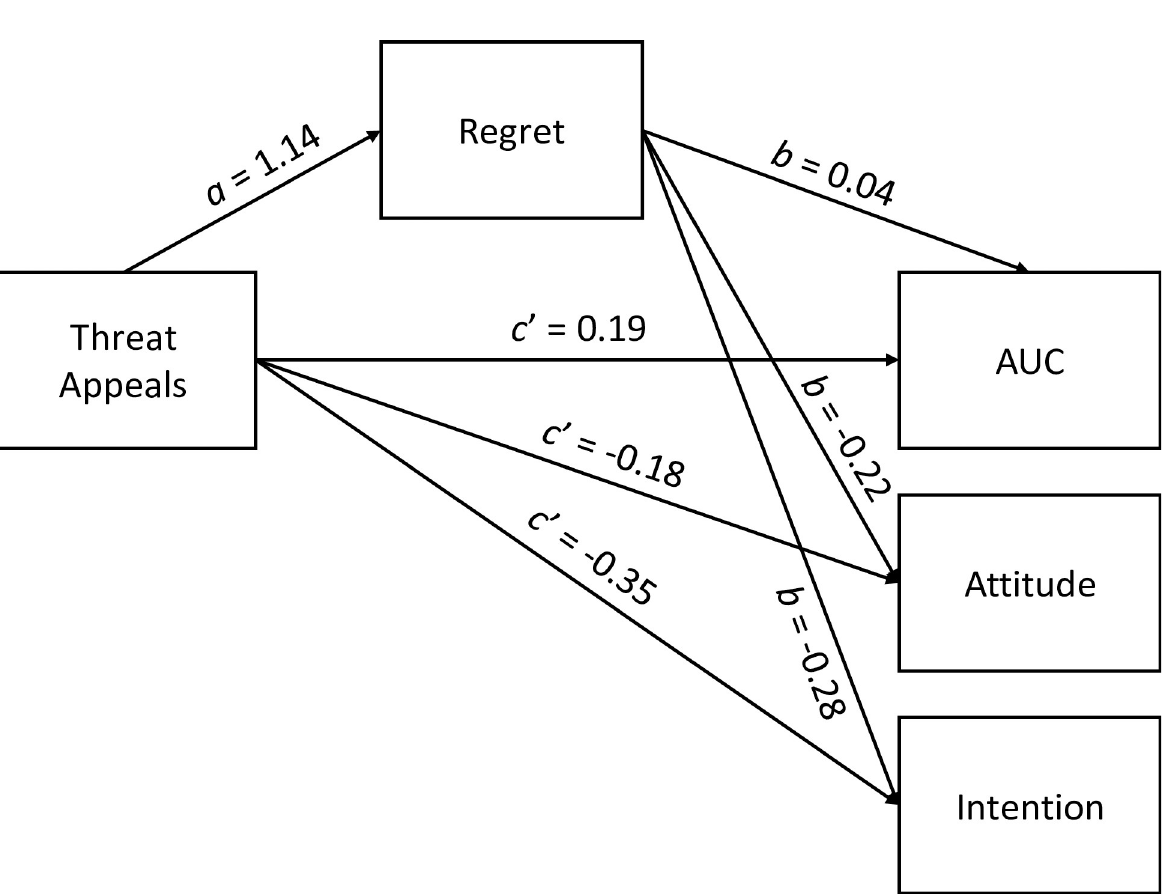
Fig 3. Diagram of the mediator models with regret as potential mediators between threat appeals and AUC, attitude, and intention. ab = indirect effect. c’ = direct effect. The values indicate unstandardized